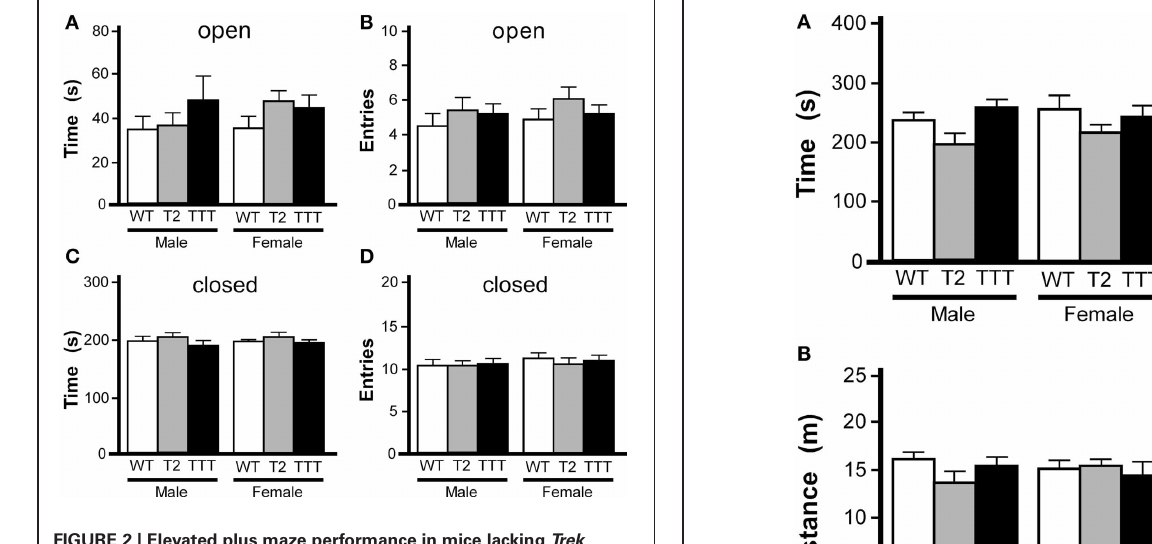
FIGURE 2 | Elevated plus maze performance in mice lacking Trek channels. Wild-type (WT, white), Trek2 − / − (T2, gray), and Trek1/2 / Traak − / − (TTT, black) mice were evaluated in a 5min (300s) EPM test ( n = 8–19 per group). No genotype-dependent differences were observed with respect to male or female mice in time spent in (A) [male: F ( 2 , 40 ) = 0 . 8, P = 0 . 46; female: F ( 2 , 49 ) = 1 . 4, P = 0 . 25] or number of entries into (B) [male: F ( 2 , 40 ) = 1 . 9, P = 0 . 16; female: F ( 2 , 49 ) = 0 . 9, P = 0 . 41] the open arms. Likewise, no significant differences were observed with respect to genotype in time spent in (C) [male: F ( 2 , 40 ) = 0 . 5, P = 0 . 59; female: F ( 2 , 49 ) = 0 . 1, P = 0 . 93] or number of entries into (D) [male: F ( 2 , 40 ) = 0 . 03, P = 0 . 97; female: F ( 2 , 48 ) = 0 . 3, P = 0 . 77] the closed arms.